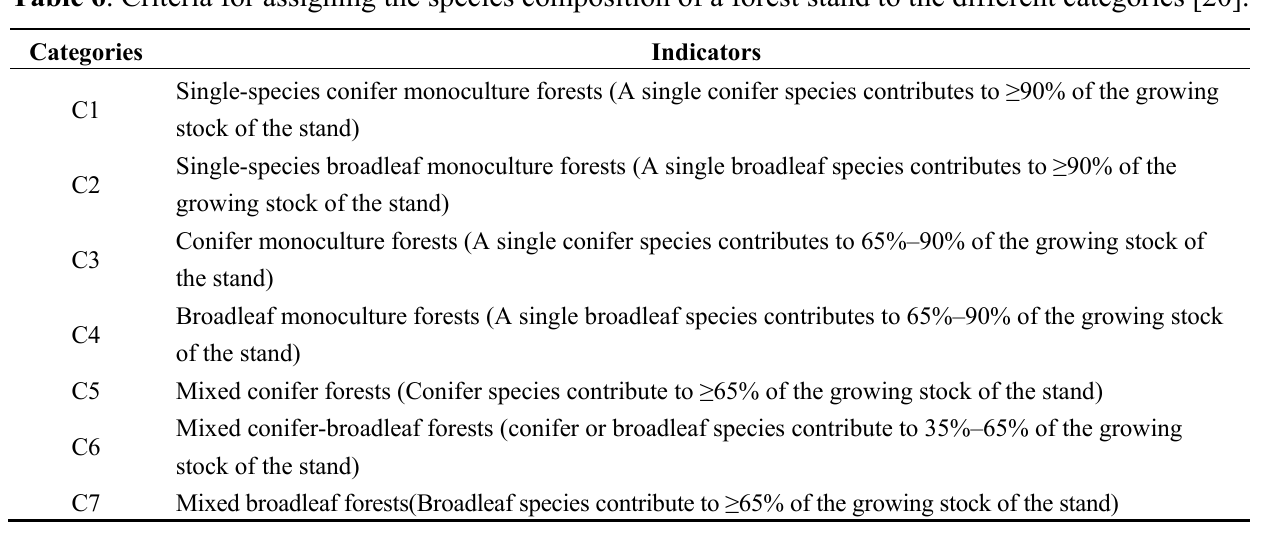
Table 6 . Criteria for assigning the species composition of a forest stand to the different categories [20].